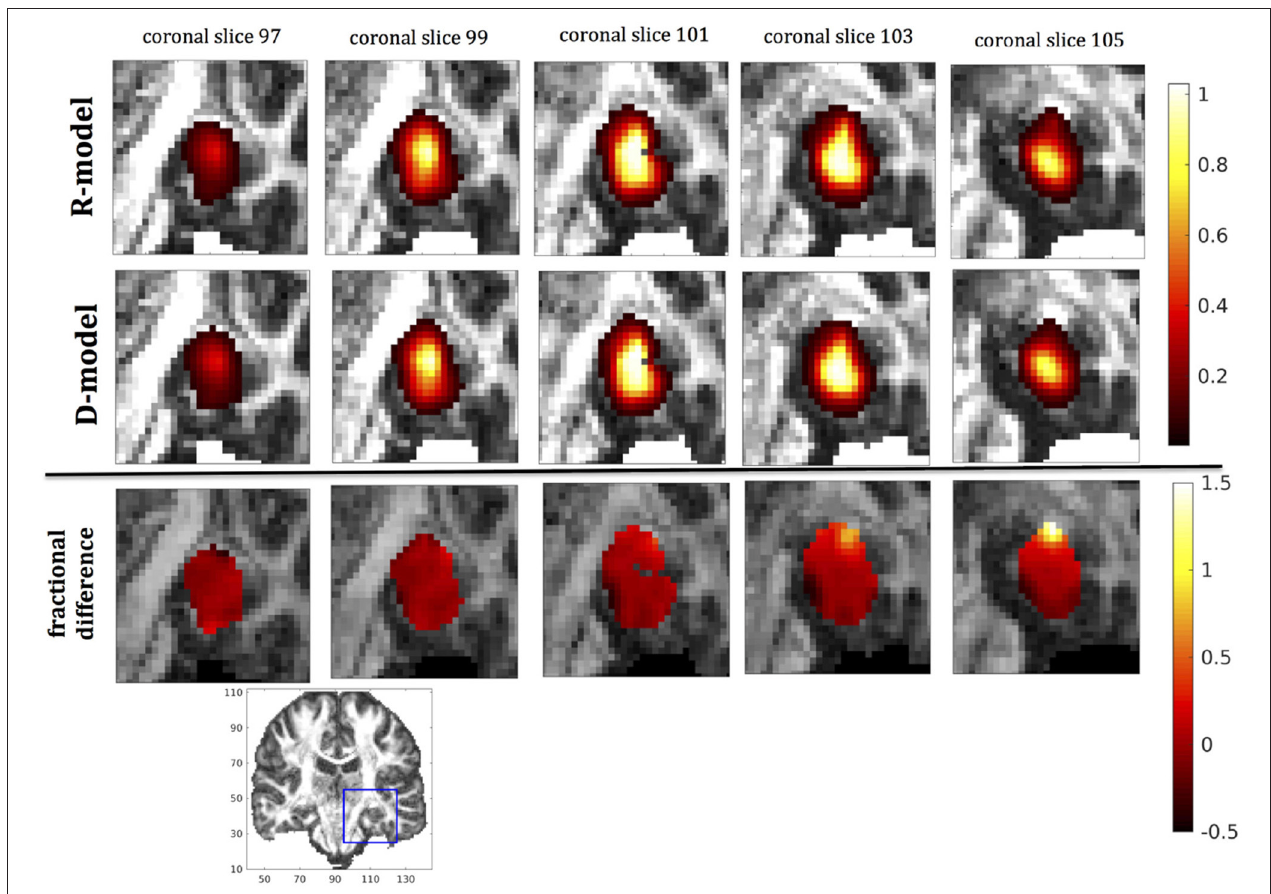
FIGURE 9 | Predicted concentrations for fast infusion in the hippocampus. (Top) R-model prediction for 5 coronal slices, (Middle) D-model prediction for the same ). The same scale has been used to plot the concentration distributions for the R- and the D- model. slices, (Bottom) fractional difference in concentrations ( C R − C D C D The FA image at the bottom shows in blue the part of the brain slices shown